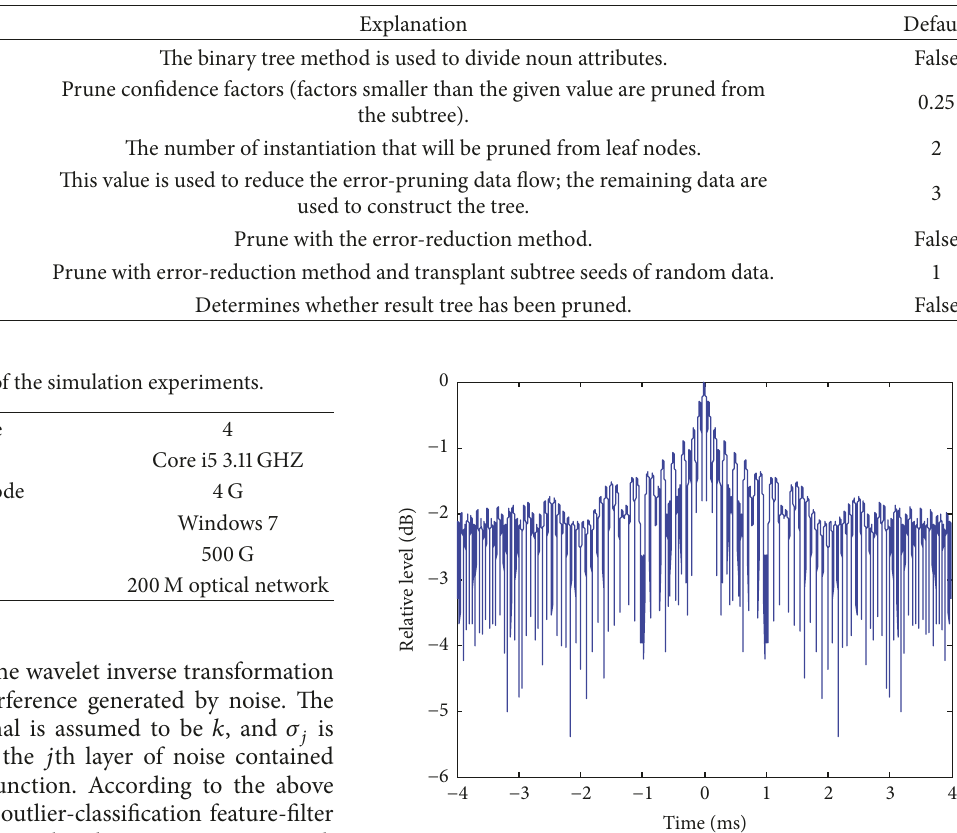
Table 1: Parameters used to classify outlier data with the decision-tree in large real-time databases.